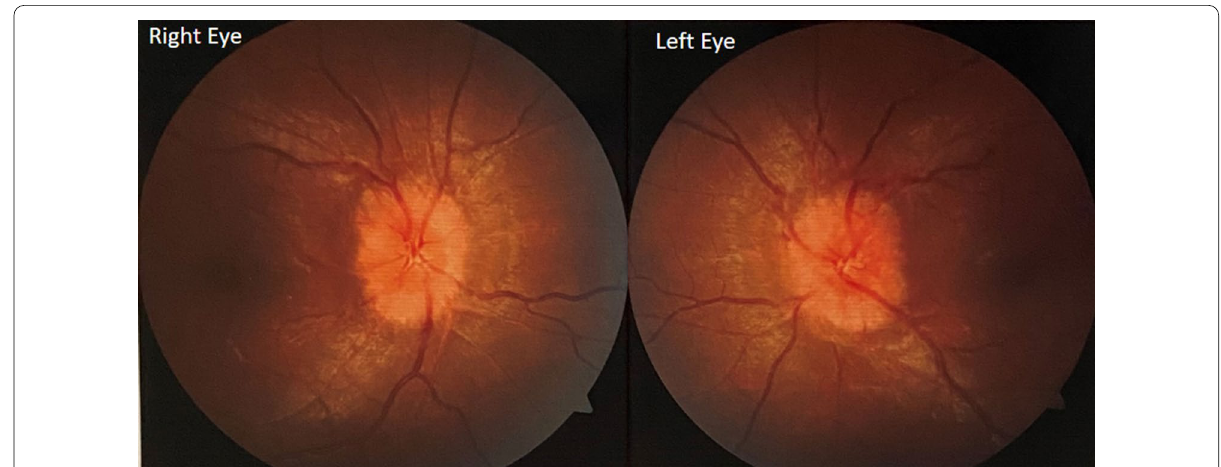
Fig. 3 Fundus of both eyes shows marked elevation of optic nerve head with obscuration of all border (blurring of disc margin) and filling of physiological cupping. Grade 3 (moderate) papilledema (FRISEN